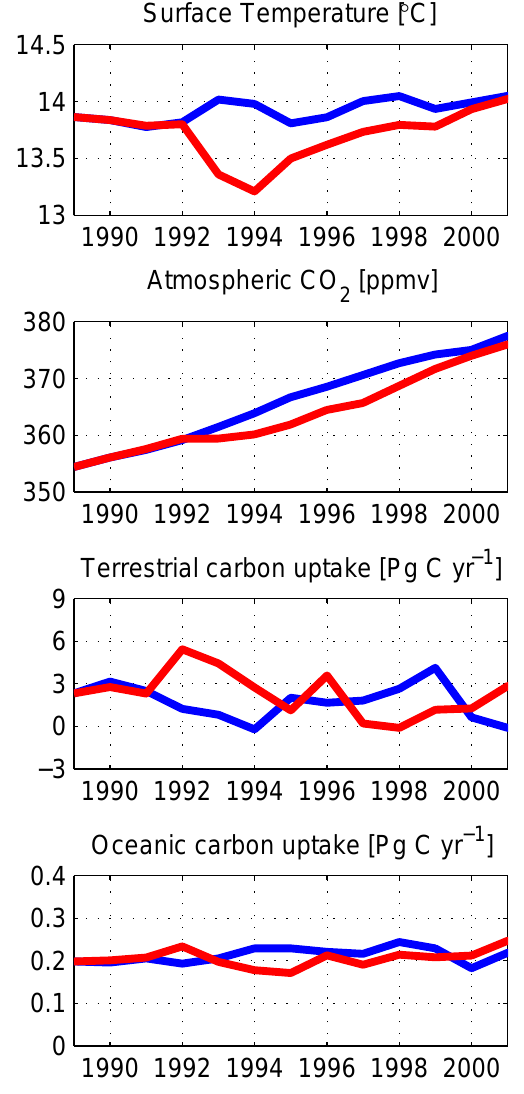
Fig. 2. Time series of global mean surface temperature, atmospheric CO 2 concentration, terrestrial and oceanic carbon uptake for the 1989–2001 period. Shown here are two simulations, with (red lines) and without (blue lines) the 1991 Mount Pinatubo